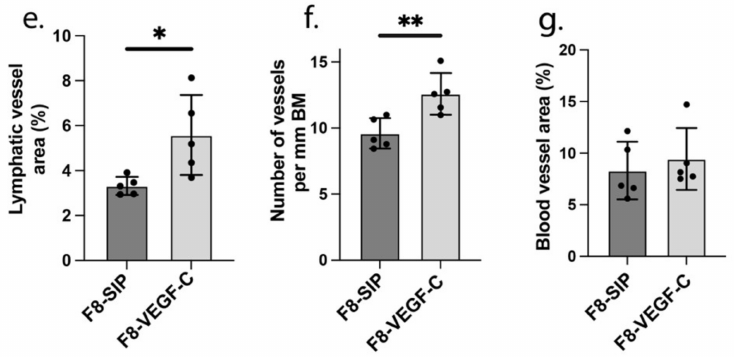
Figure 1. ( a ) Schematic representation of the experimental setup with the treatment regimen on days 7, 9, 11, and 13 (dashed arrows). X indicates the day when ear thickness in both treatment groups returned to baseline, and therefore the day when inflammation was resolved. ( b ) Representative images of uninflamed versus inflamed ears in K14-VEGF-A transgenic mice 7 days after CHS-induced inflammation. ( c ) The ear thickness of F8-SIP and F8-VEGF-C-treated mice compared to pre-challenge thickness ( n = 10 mice per group, 2-way ANOVA with Bonferroni post-test) until day 74. Ear thickness of uninflamed mice is shown for comparison ( n = 3). ( d ) Representative immunofluorescence images of ears from F8-SIP and F8-VEGF-C-treated mice stained for the lymphatic marker Lyve-1 (green), the vessel marker CD31 (red), and Hoechst 33342 (blue) on day 74 post-challenge. The dotted yellow line indicates the basement membrane (BM). Size bars: 100 µ m. ( e ) Quantification of lymphatic vessel area in % of the analyzed region of interest in F8-SIP and F8-VEGF-C-treated mice on day 74 post-challenge (expressed as mean %, n = 5 mice per group, two-tailed Student’s t -test). ( f ) Analysis of the number of lymphatic vessels in F8-SIP and F8-VEGF-C-treated mice in the region of interest on day 74 post-challenge (expressed as mean number per mm basement membrane length, n = 5 mice per group, two-tailed Student’s t -test). ( g ) Quantification of the blood vessel area as a % of the analyzed area on day 74 post-challenge (expressed as mean %, n = 5 mice per group, two-tailed Student’s t -test). One representative of two independent experiments is shown. All data are presented as mean ± SD. * p < 0.05, ** p < 0.01, **** p <